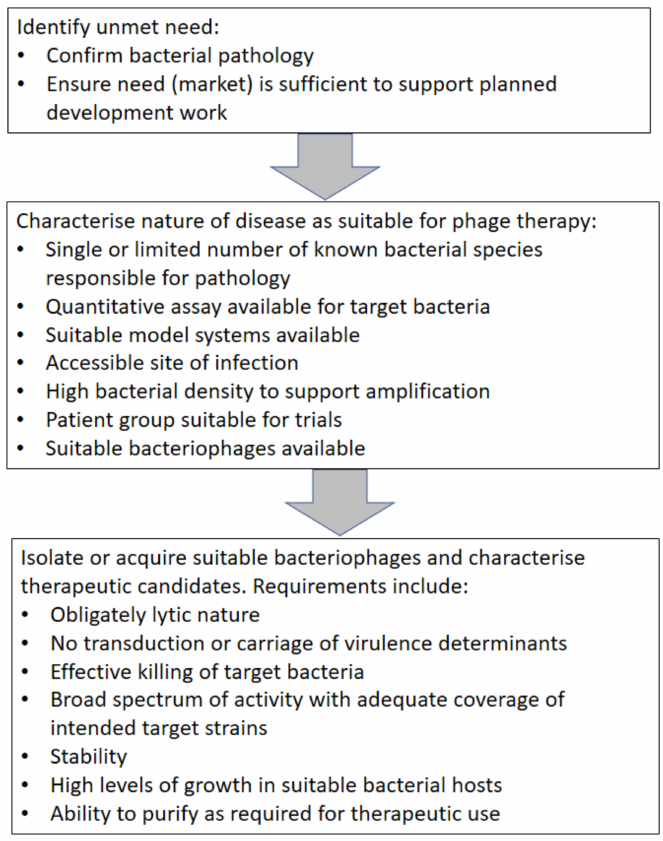
Figure 2. Steps in the selection of an initial target disease for phage